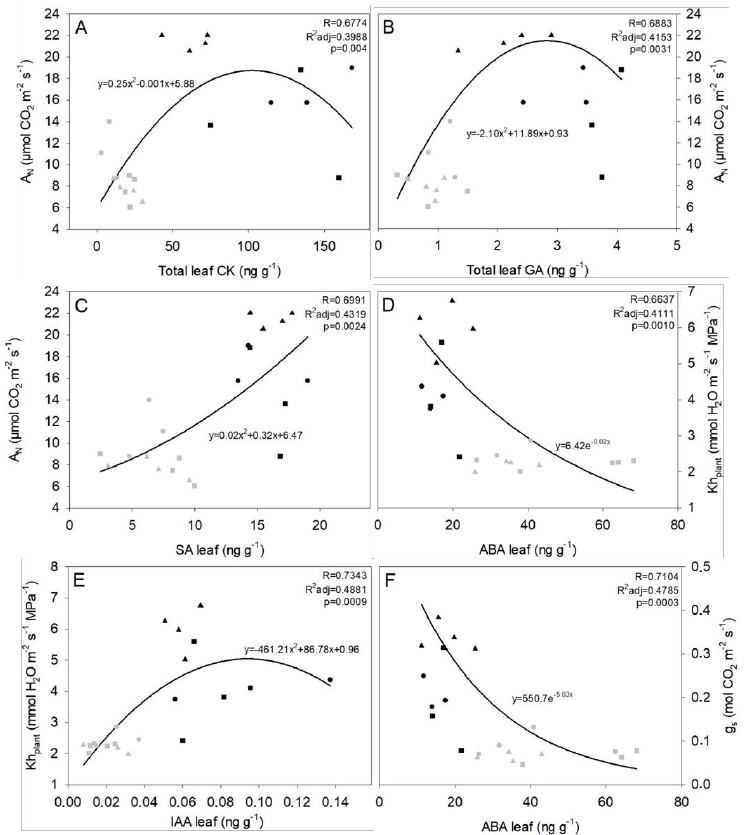
Figure 4. Correlation graphs between physiology and phytohormones. ( A ) Net photosynthesis (A N )-cytokinins (CK) regression, ( B ) net photosynthesis (A N )gibberellins (GA) regression, ( C ) net photosynthesis (A N )-salicylic acid (SA) regression, ( D ) whole plant hydraulic conductivity (Kh plant )-abscisic acid (ABA) regression, ( E ) whole plant hydraulic conductivity (Kh plant )-indole-3-acetic acid (IAA) regression and ( F ) stomatal conductance (g s )-abscisic acid (ABA) regression. The rootstocks (1103P ( ▲ ), R110 ( ● ) and 161-49C ( ∎ )) and treatments (WW: black; WS: grey) are represented on each graph. The green trend line shows that the relationship is between leaf parameters. Statistical parameters (R, R 2 adjusted and p -value) also are indicated.